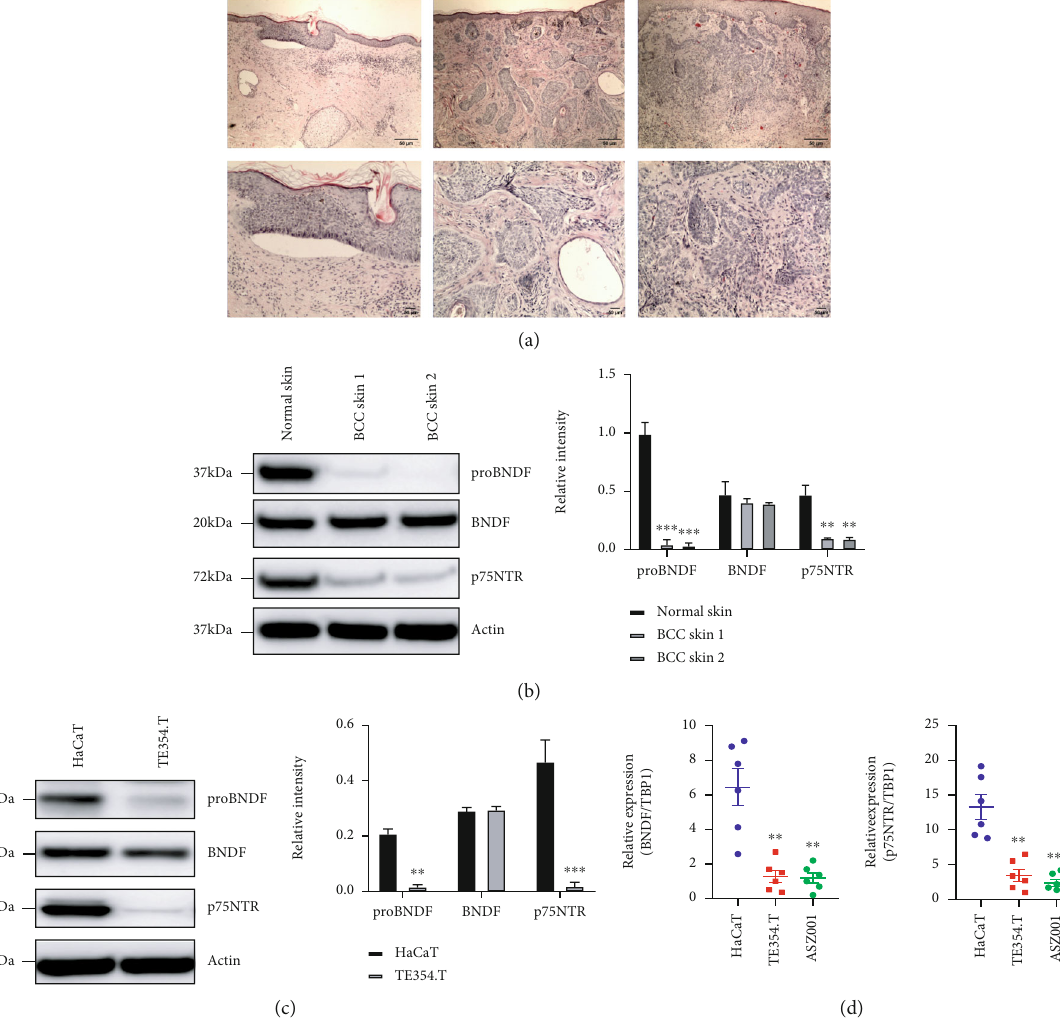
Figure 1: The expression level of proBDNF/p75NTR is downregulated in the BCC patients and cell lines. (a) Histology analysis in primary BCC tissues compared to normal skin samples. (b) Compared to the normal skin, the protein expression levels of p75NTR/proBDNF in BCC samples were signi fi cantly downregulated. ∗ P < 0 : 01 , ∗∗ P < 0 : 01 , ∗∗∗ P < 0 : 001 . (c, d) Compared to HaCaT cell, the protein expression levels and transcriptional levels of p75NTR/proBDNF in TE354.T and AZS001 cell lines were signi fi cantly downregulated. ∗ P < 0 : 01 , ∗∗ P < 0 : 01 , ∗∗∗ P < 0 : 001